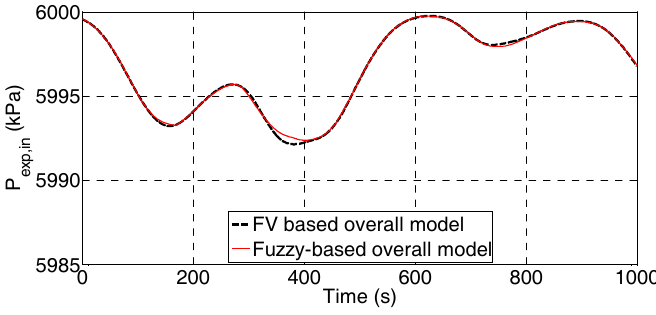
Figure 16. Prediction of expander inlet pressure with the fuzzy and FV evaporator-based overall models. Table 7. Mean values of operating parameters with respect to random inputs.